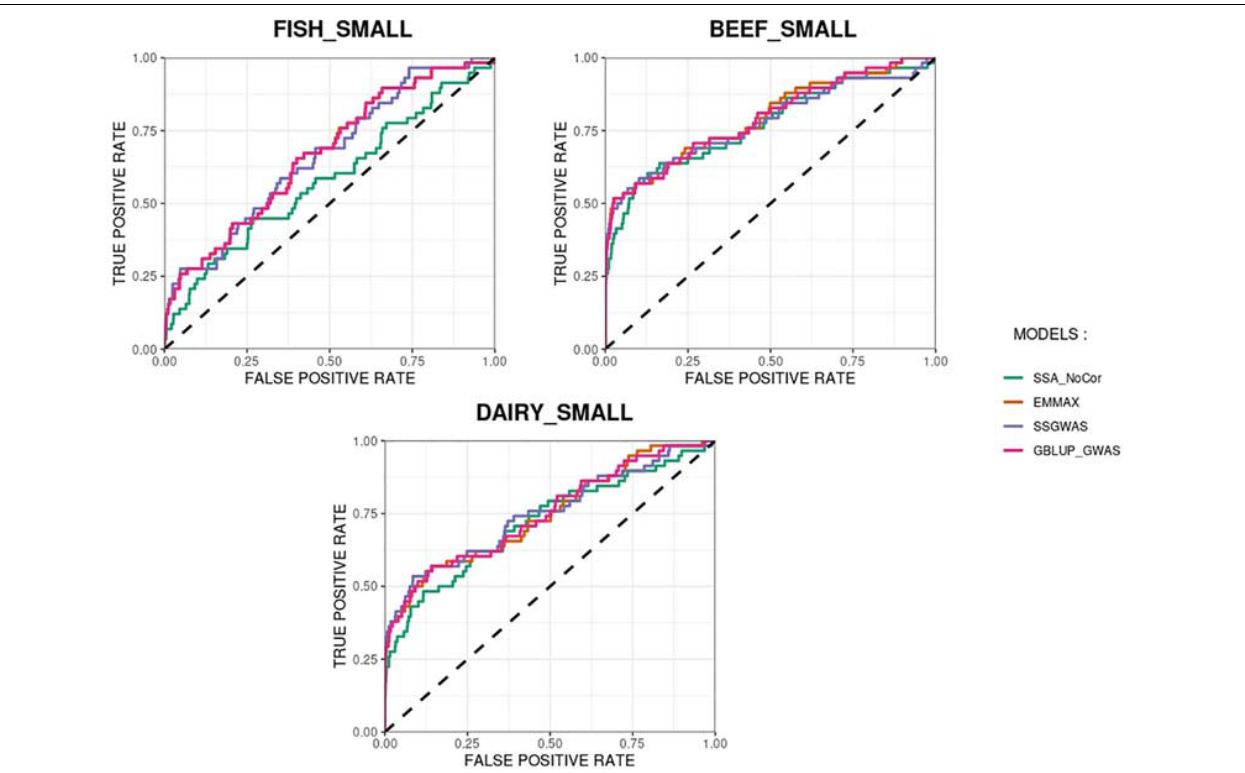
FIGURE 11 | Receiver operating characteristic (ROC) curves for GWAS results for the small populations of fish,beef cattle, dairy cattle with ten daughters per sire. The association methods used were single-SNP analysis without correction for population structure (SSA-NoCor), efficient mixed-model association expedited (EMMAX), single-step GWAS (ssGWAS), and genomic best linear unbiased prediction GWAS (GBLUP-GWAS). The dashed line has slope equal to one and null intercept.